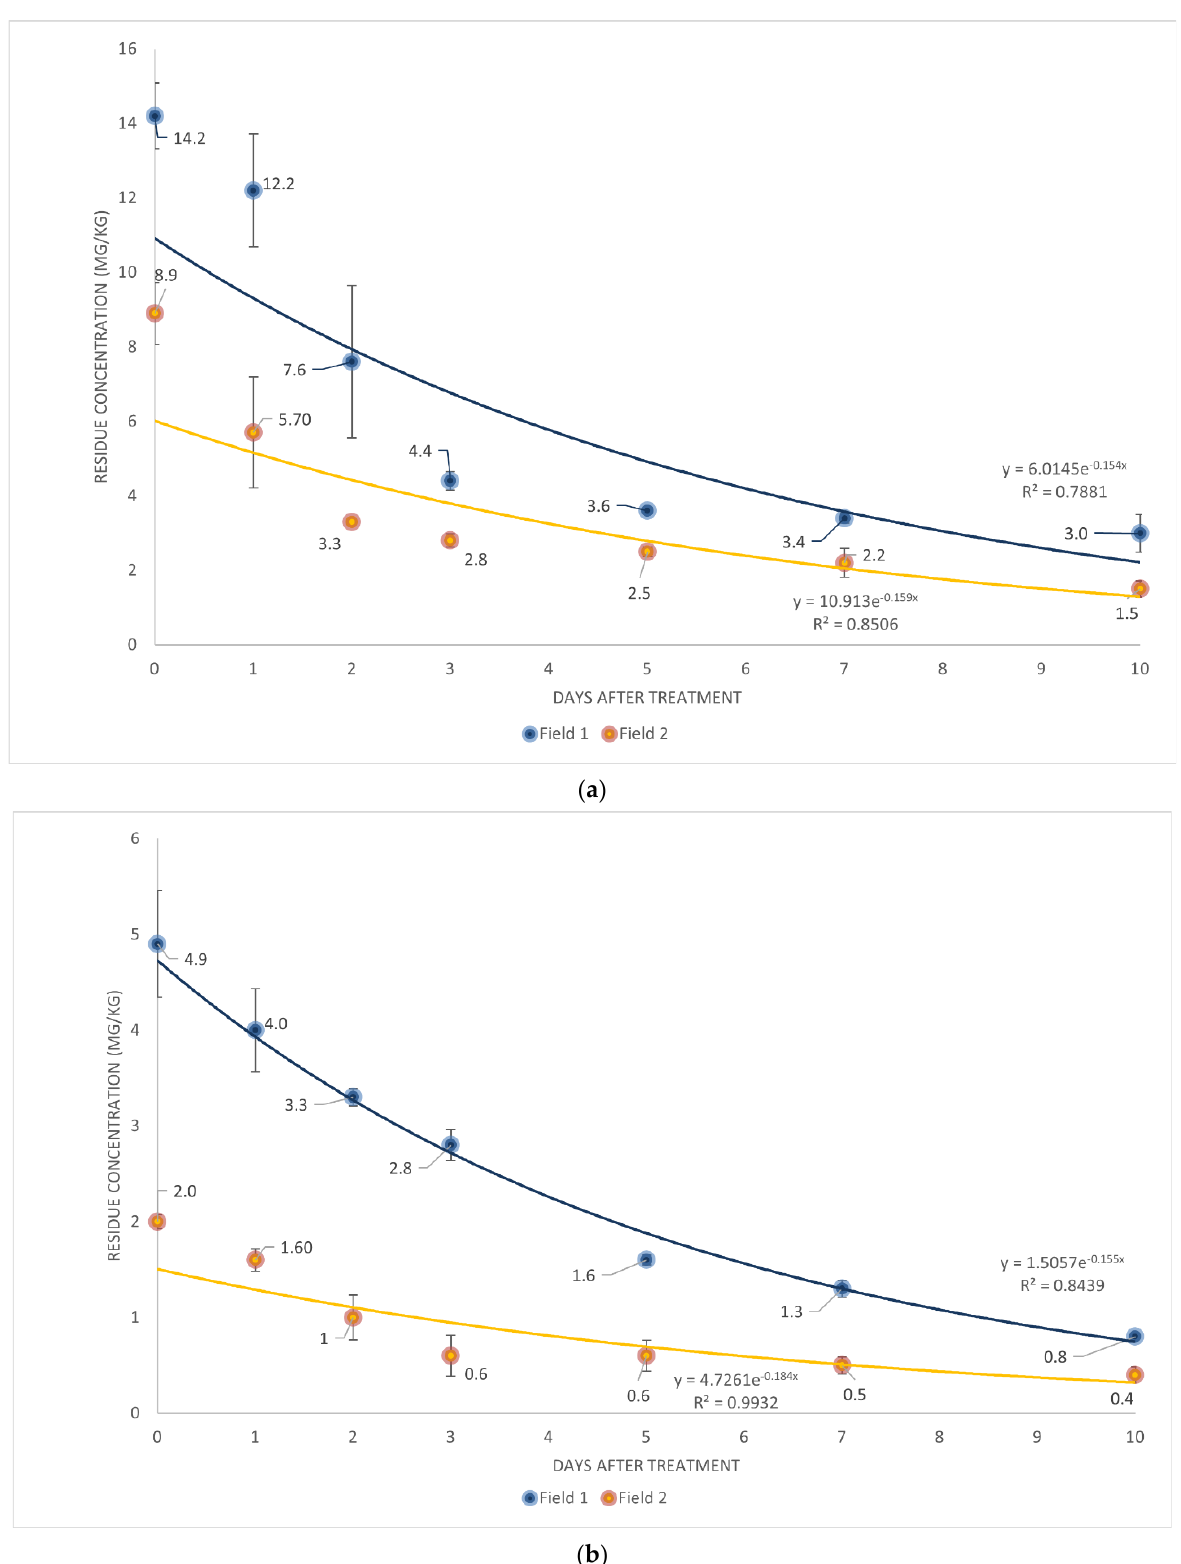
Figure 1. Dissipation kinetics of ( a ) spirodiclofen and ( b ) tebufenpyrad.